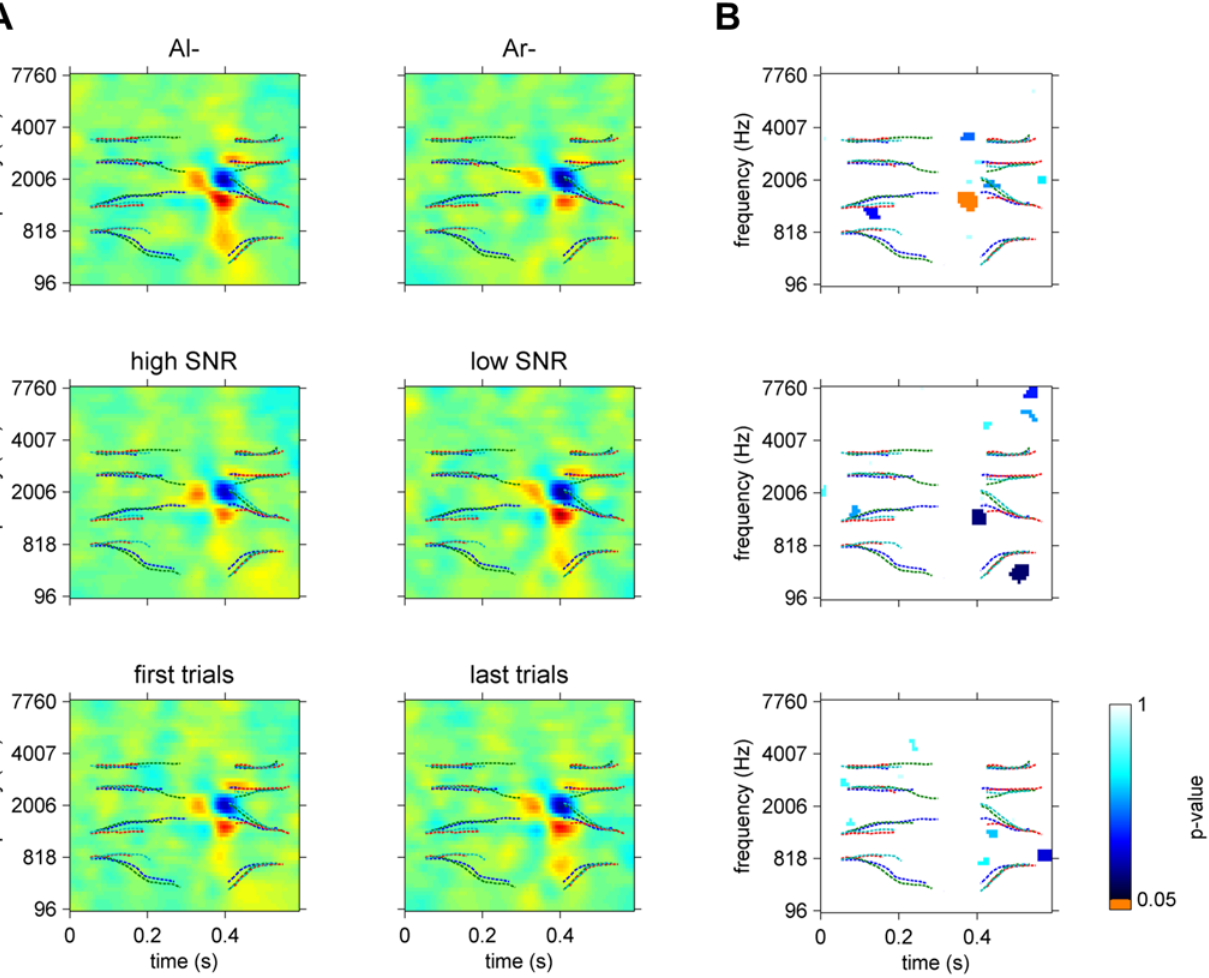
Fig 5. ACIs estimated on subsets of the data. A. Mean ACI for the 16 participants collectively, for conditions Al-, Ar-, high SNR, low SNR, firsttrials and lasttrials. Each individual ACI was estimated on 5,000 trials, with l ~ = 1.191. In each ACI, the weights are divided by their maximum absolute value, and the formant trajectories are superimposed (same legend as in Fig. 6). B. Position of significant (orange) and non-significant clusters for each comparison (cluster- based non parametric test, p <